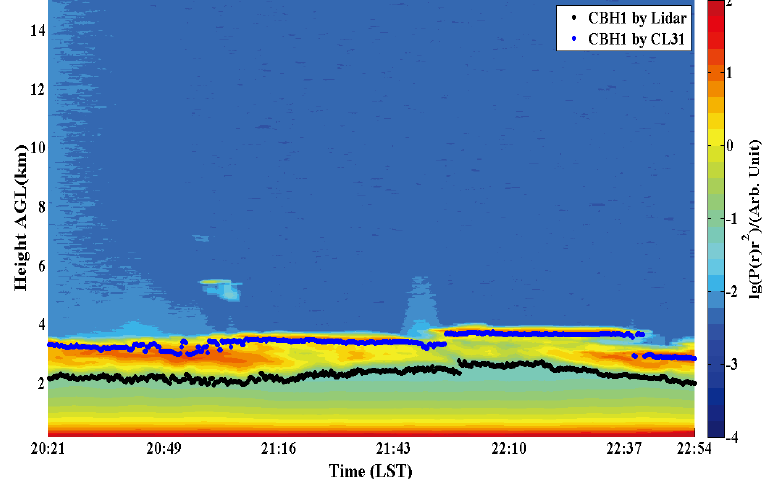
Figure 9. Atmospheric backscattered signal of WACAL at 20:21–22:54, 12 August 2014 and CBH1 measured by WACAL ( black ) and CL31 ( blue ).